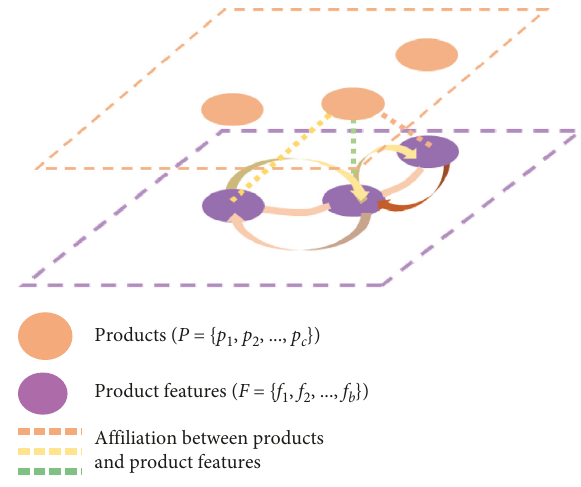
Figure 7: Co-creation product